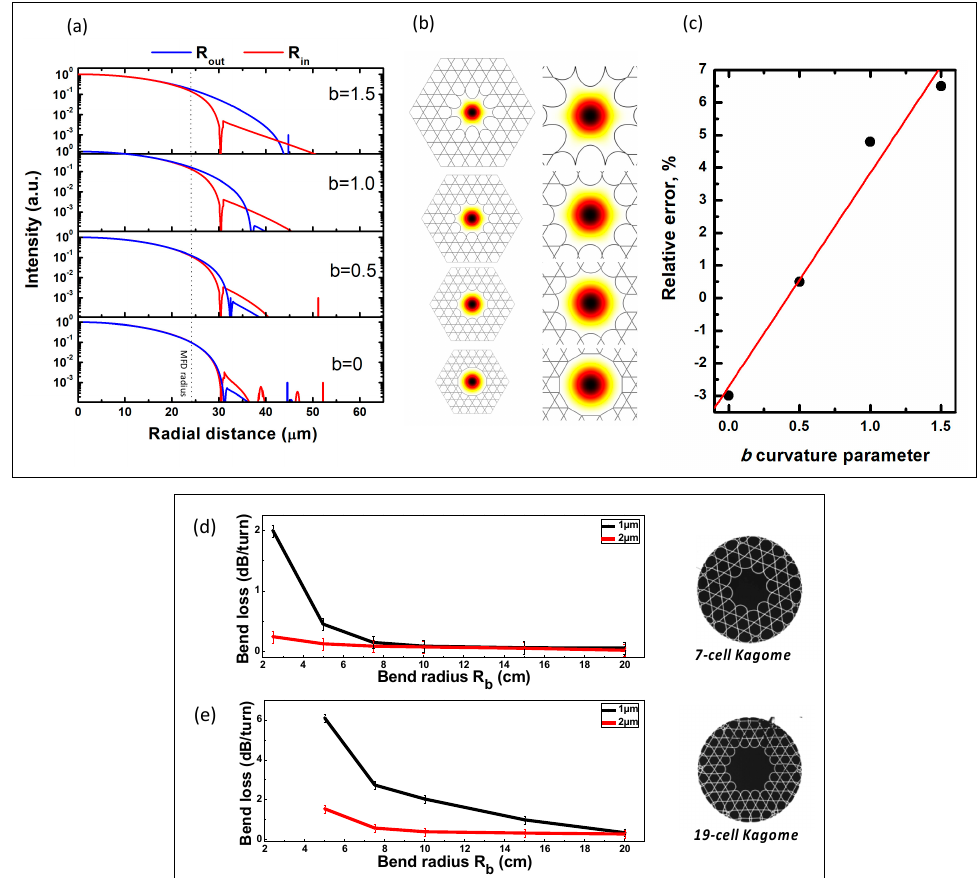
Figure 23. ( a , b ) Evolution of the mode field diameter of IC HCPCF HE 11 core mode profile with negative curvature b . ( c ) Relative error on MFD when Kagome IC-HCPF is approximated to a glass capillary with a radius equal to the inner radius of the hypocycloid core contour. (Reprinted with permission from Reference [63], OSA, 2013.) Experimental bend loss evolution versus bend radius R b for ( d ) 7-cell and ( e ) 19-cell Kagome HCPCF at 1 µm (black curves) and 2 µm (red curves) (reprinted with permission from Reference [65], OSA, 2018).